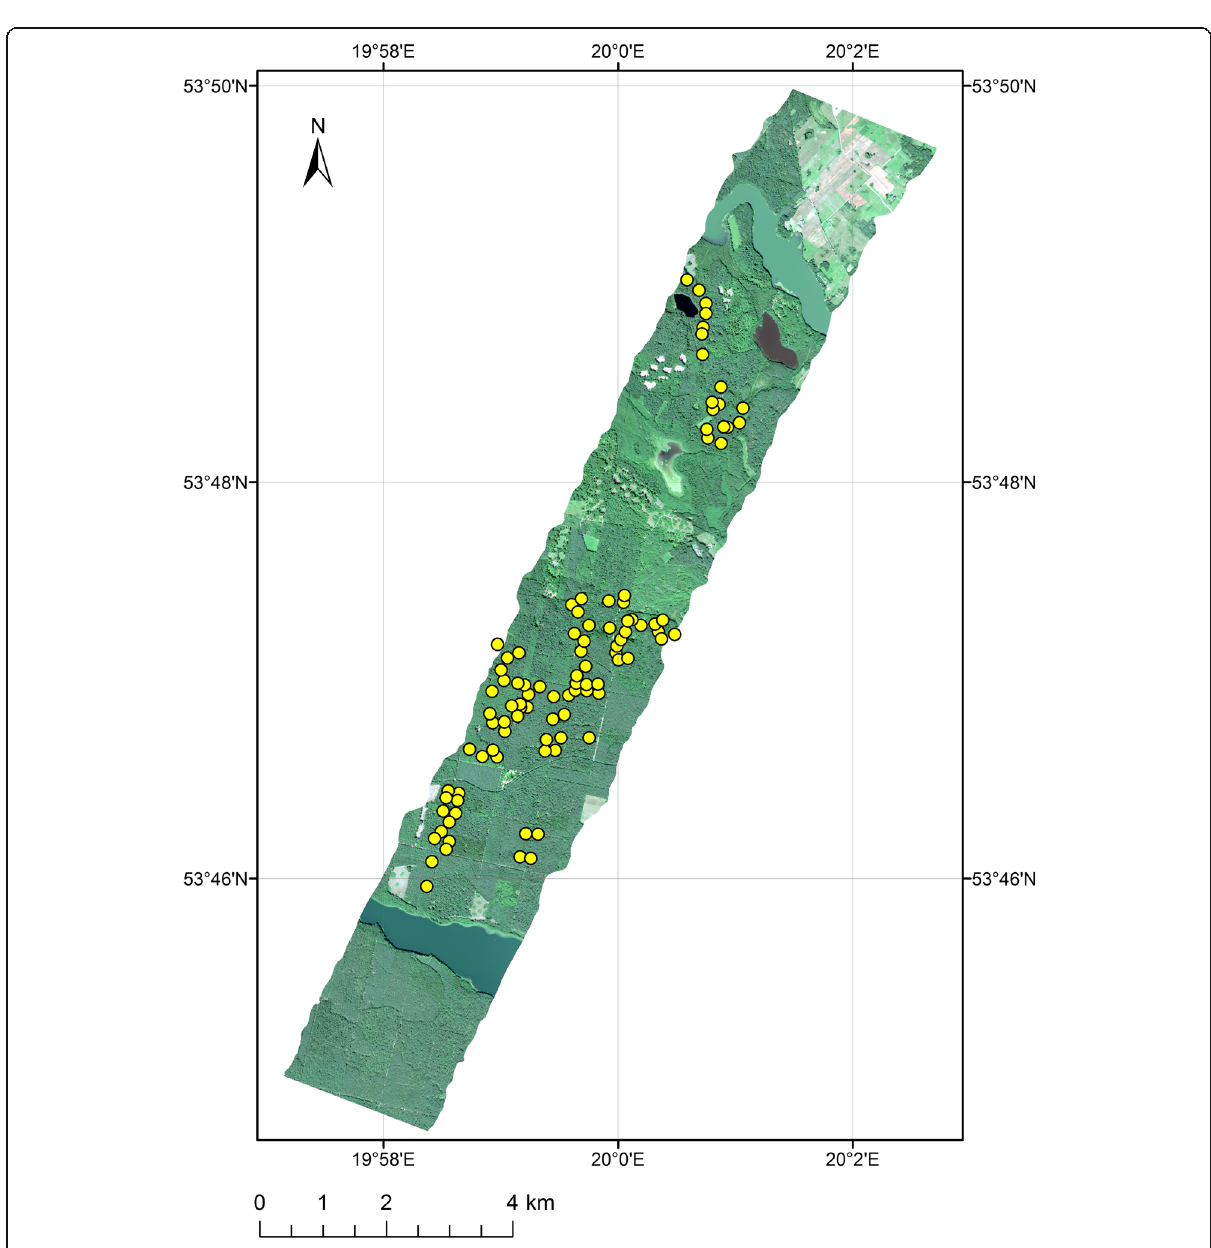
Fig. 2 AISA EAGLE hyperspectral image (natural colour composite) constructed by MGGP AERO; the sample